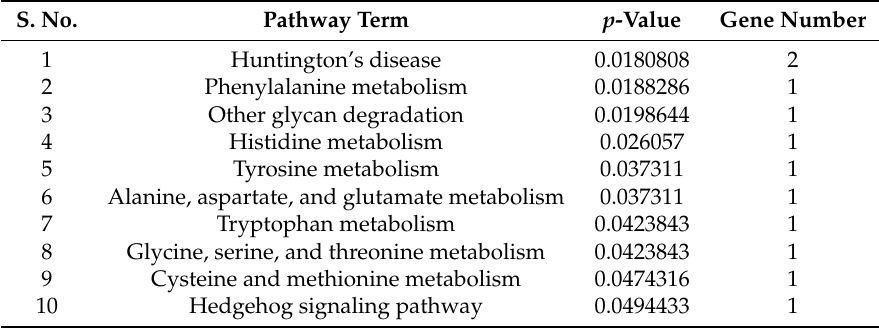
Table 4. Number of substantially enriched pathways along with number of genes of downregulated DEGs computed by Kyoto Encyclopedia of Genes and Genomes (KEGG) pathway analysis.